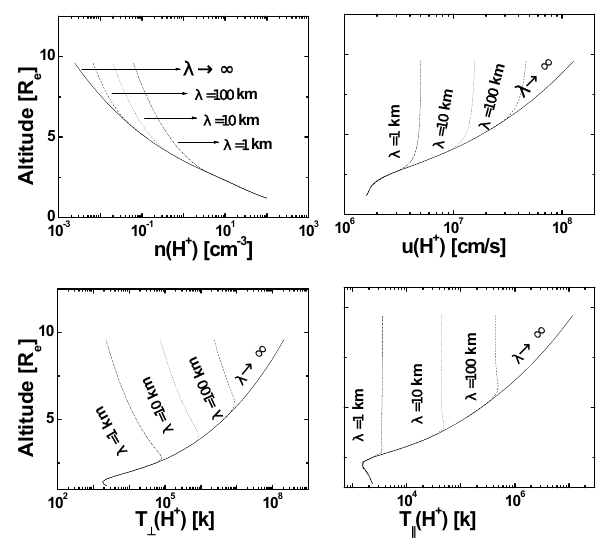
Fig. 4. Altitude profiles of the lower order H + moment for dif- ferent electromagnetic turbulence wavelengths ( λ ⊥ ) . The wave- lengths considered here are λ ⊥ →∞ (solid), λ ⊥ = 100km (dashed), λ ⊥ = 10km (dotted), and λ ⊥ = 1km (dashed dotted). The H + mo- ments considered here are: density n(H + ) (top left), drift veloc- ity u( H + ) (top right), perpendicular temperature T ⊥ (cid:0) H + (cid:1) (bottom left), and parallel temperature T k (cid:0) H + (cid:1) (bottom right).